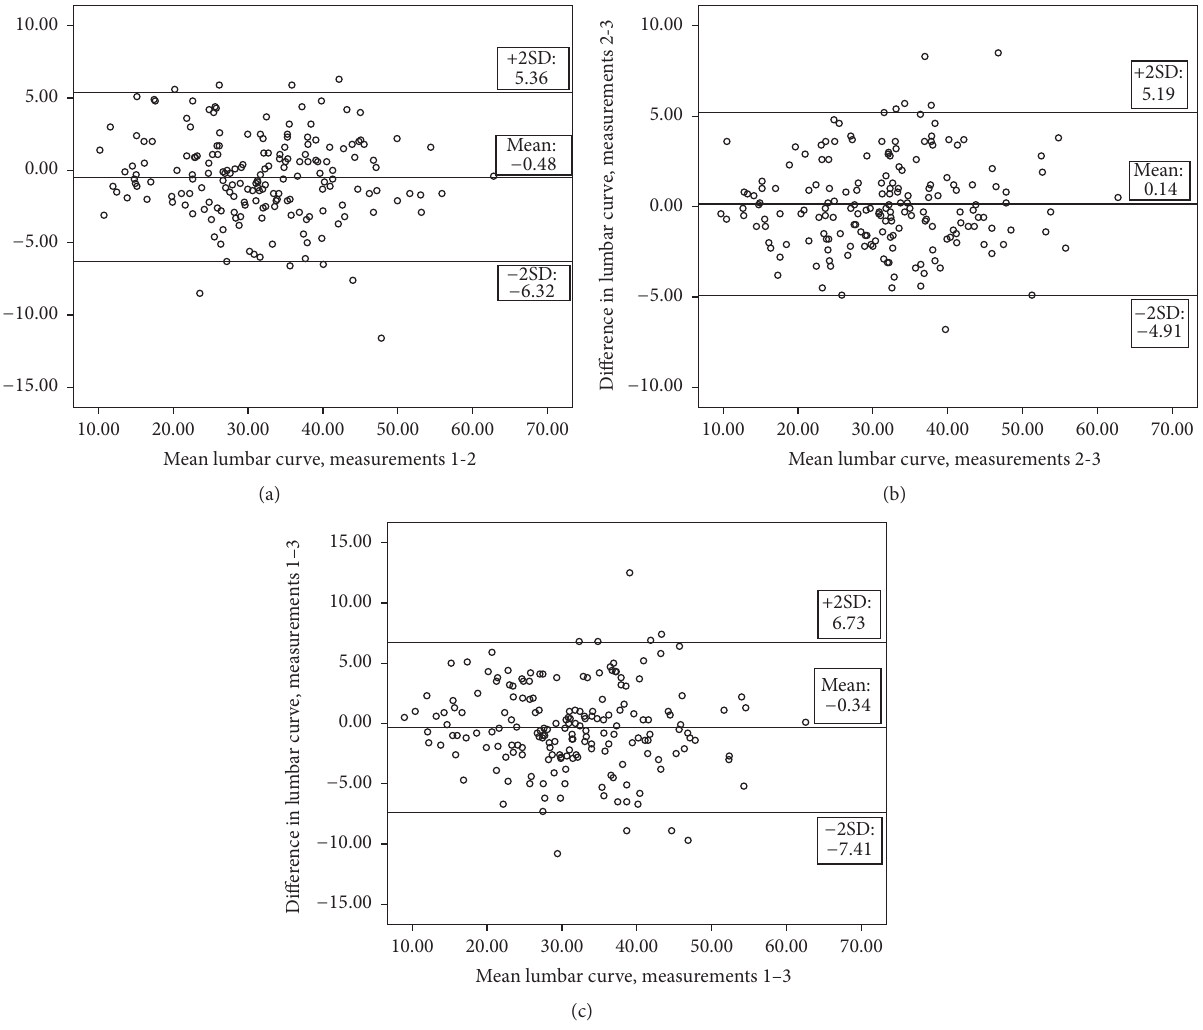
Figure 2: Bland and Altman plots for lumbar curve measurements, indicating mean differences and 95% limits of agreement between (a) measurements 1 and 2, (b) measurements 2 and 3, and (c) measurements 1 and